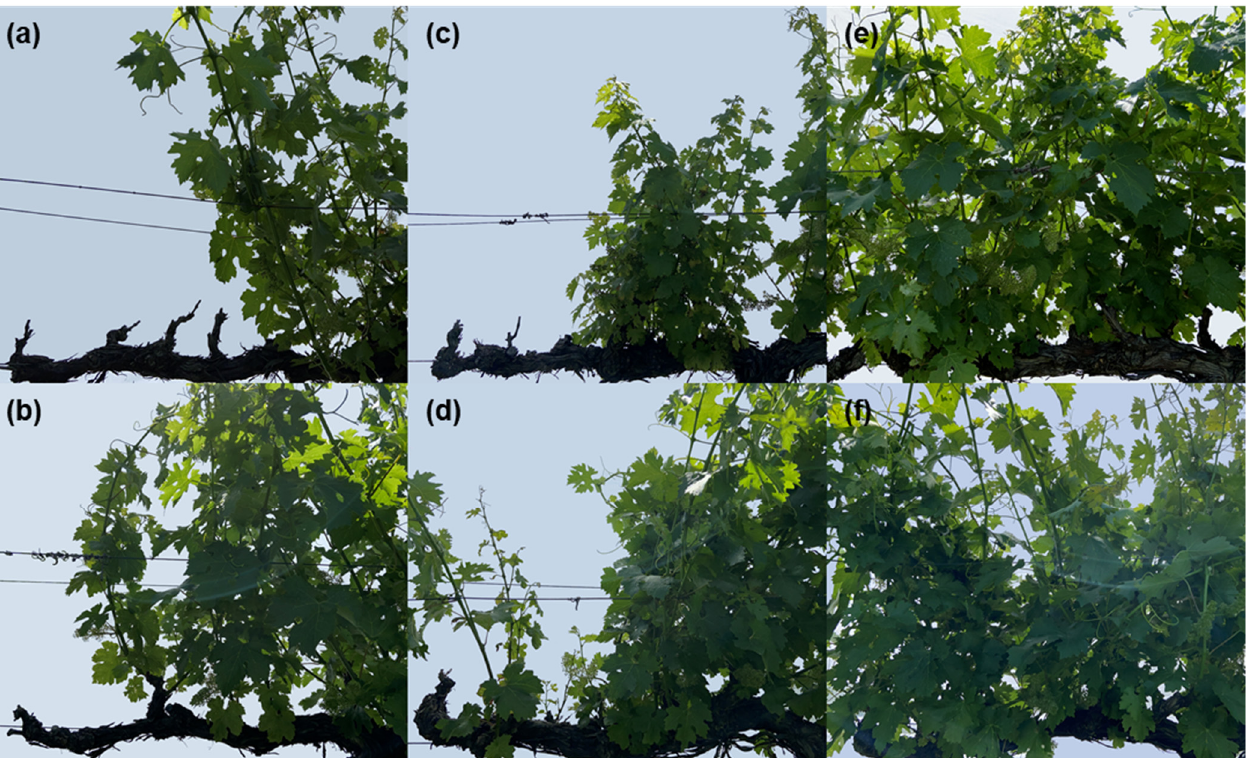
Figure 3. Presence of cordon dieback and foliar symptoms of Eutypa dieback. ( a , b ) Cordon dieback but no foliar symptoms; ( c , d ) cordon dieback and foliar symptoms (stunted shoots); ( e , f )